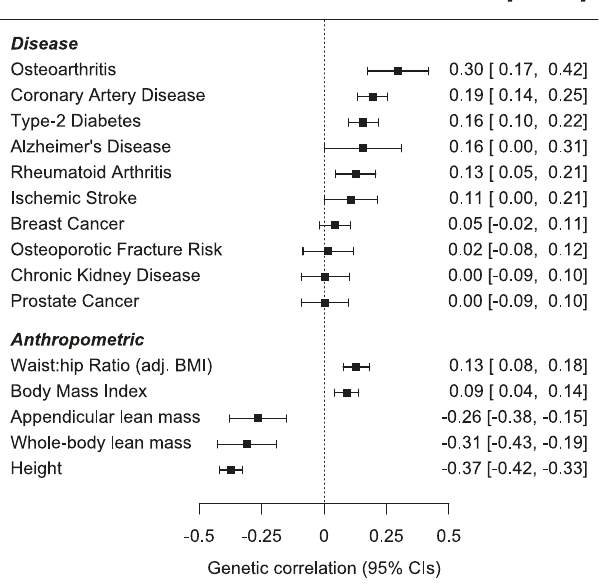
Fig. 2 Low grip strength genetic correlations with ten common diseases and fi ve anthropometric traits. Genome-wide genetic correlations between low muscle strength and published summary statistics for common age-related diseases and low muscle strength risk factors. N = meta-analysis of 256,523 Europeans (biologically independent samples) aged 60 or older from 22 cohorts. Data presented are genetic correlation (rG) ± 95% Con fi dence Intervals from LD-Score Regression analysis of 1.2 million SNPs. Full results available in Supplementary Table